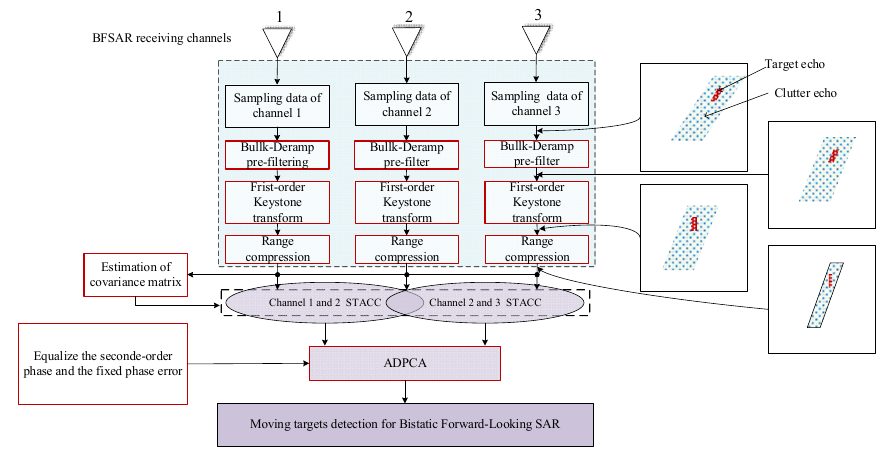
Figure 5. The procedure of the proposed method.